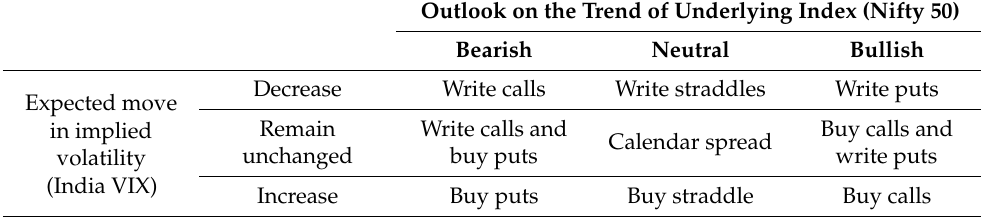
Table 9. Options strategy for hedging and